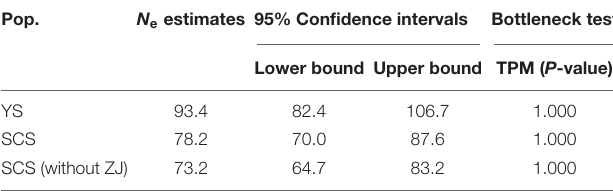
Number of samples (N), number of alleles (A), effective number of alleles (A e ), allele richness (A r ), heterozygosity observed (H o ), heterozygosity expected (H e ), F is values, and probability of significant deviation from Hardy–Weinberg equilibrium (P) are given for each population and locus. Values underlined indicate statistical significance, P < 0.004, after Bonferroni correction = 0.05/12. TABLE 4 | Estimates and 95% confidence intervals of effective population size ( N e ) based on linkage disequilibrium and the detection of bottlenecks based on Wilcoxon’s test for eight samples and the two genetic clusters of M. meretrix using six microsatellite loci. Pop.